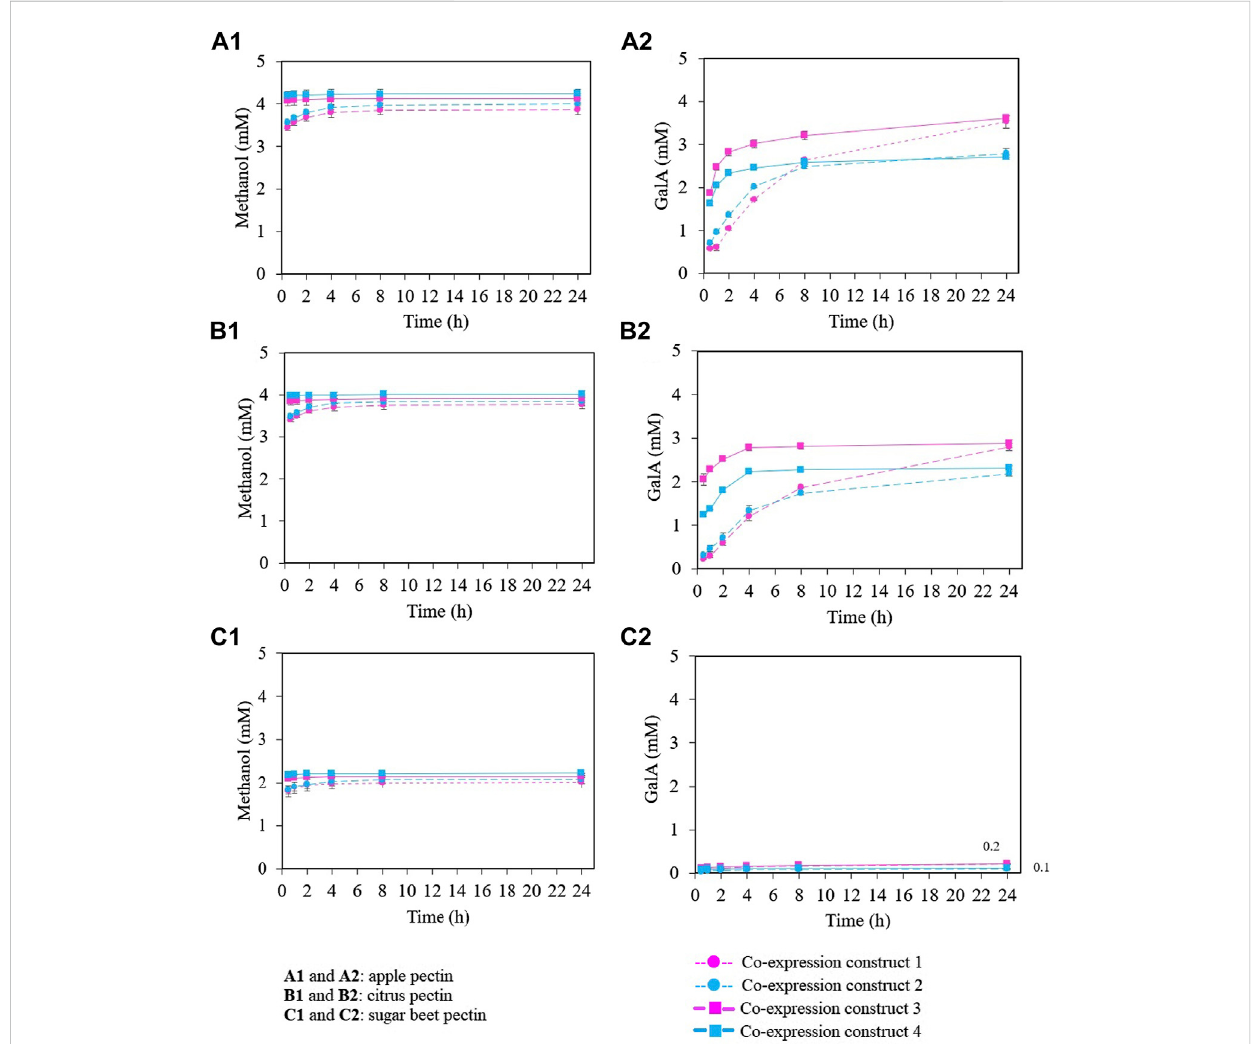
FIGURE 3 Synergistic activity between BLI09 PME with either TMA01 or BLI04 exo-PG as co-expressed enzymes using different pectic substrates. (A) Apple pectin, (B) citrus pectin and (C) sugar beet pectin. (A1,B1,C1) methanol release and (A2,B2,C2) GalA quanti fi cation.